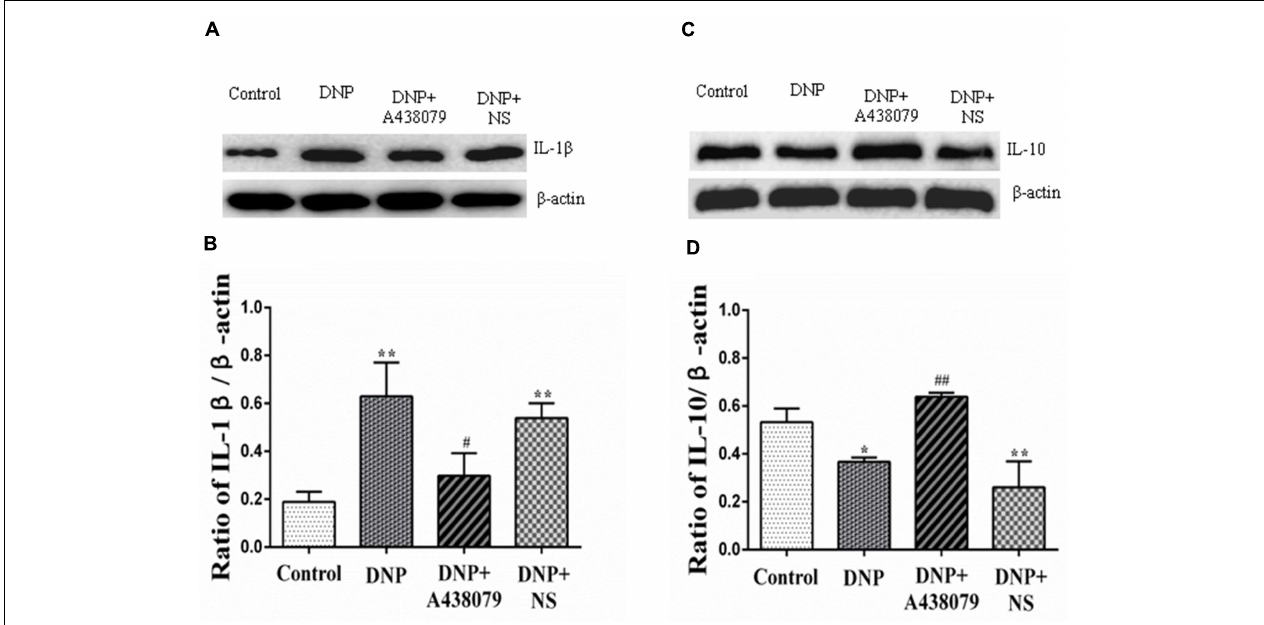
FIGURE 4 | The relative levels of IL-1 β and IL-10 in the DRG were detected by Western blotting. (A) SDS-PAGE band of IL-1 β in the DRG in each group of experimental rats. (B) The relative levels of IL-1 β in the DRG from each group of experimental rats. (C) SDS-PAGE band of IL-10 in the DRG in each group of experimental rats. (D) The relative levels of IL-10 protein in the DRG from each group of experimental rats. The relative level of the IL-1 β protein in the DRG from the DNP group was higher than that in the control group, while a lower level of IL-1 β was observed in the DRG from the DNP + A438079 group than in the DNP group. In contrast, the relative level of the IL-10 protein in the DRG from the DNP group was lower than that in the control group, while a higher level of IL-10 was detected in the DRG in the DNP + A438079 group than in the DNP group. The data are presented as the mean ± SEM, n = 6; compared with the control group, * P < 0.05, ** P < 0.01; compared with the DNP group, # P < 0.05, ## P <